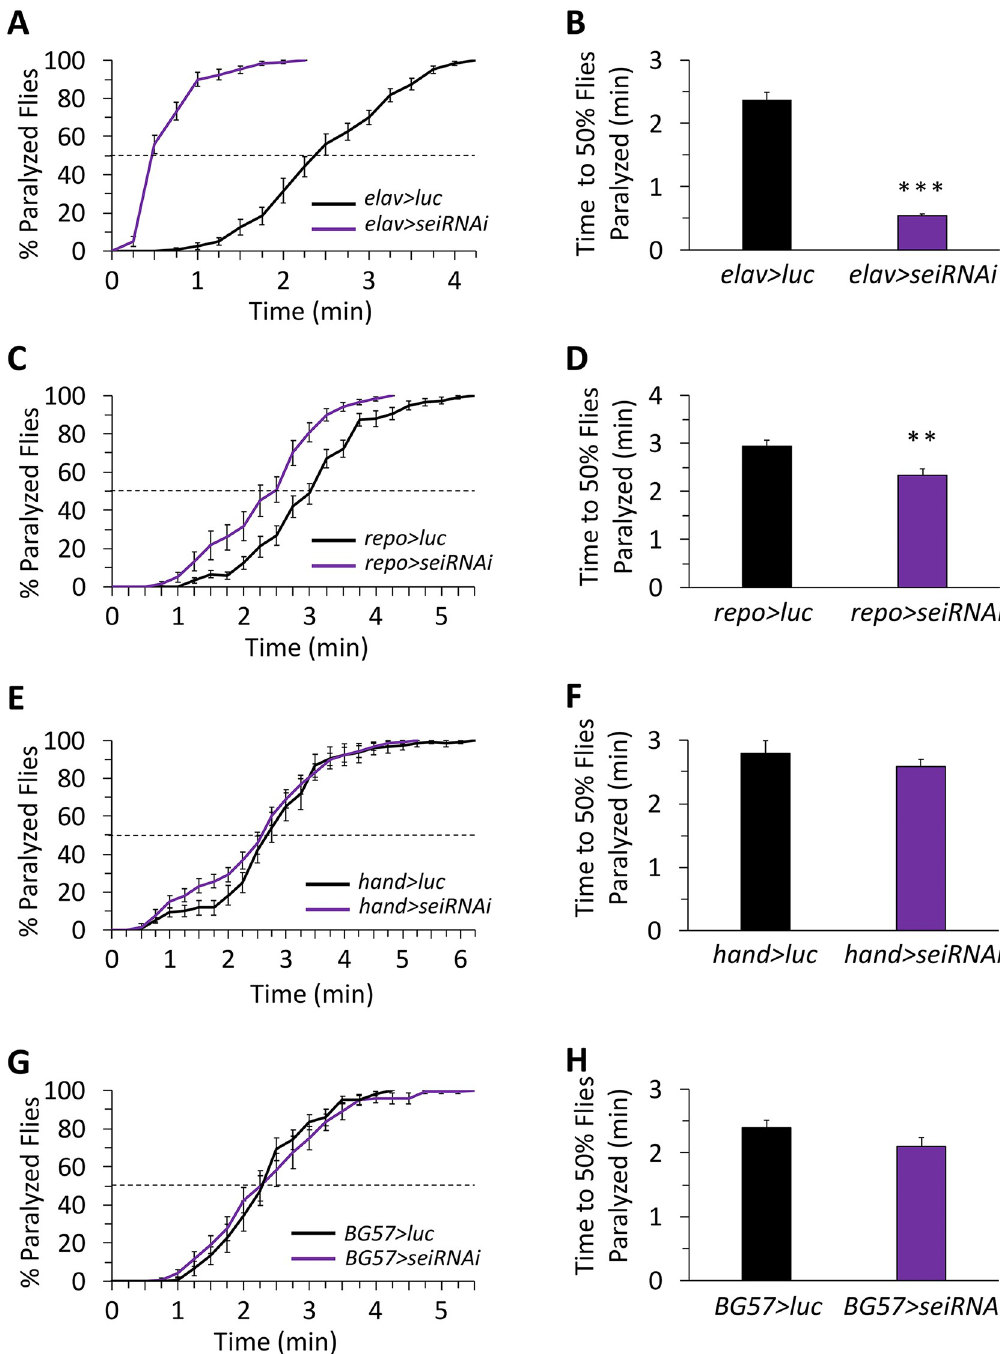
Fig 3. sei expression is required in neurons and glia for the homeostatic response to acute heat stress. A cell-type specific RNAi-dependent sei knockdown screen. A-B ) Neurons ( elav-GAL4 ); C-D ) glia ( repo - GAL4 ); E-F ) heart ( hand-GAL4 ); G-H ) muscle ( BG57-GAL4 ). n = 12 vials/genotype, 10 flies per vial, placed in 41–42˚C water. Data are presented as mean ± SEM, �� p < 0.01, ��� p < 0.001 (Student’s t -test).